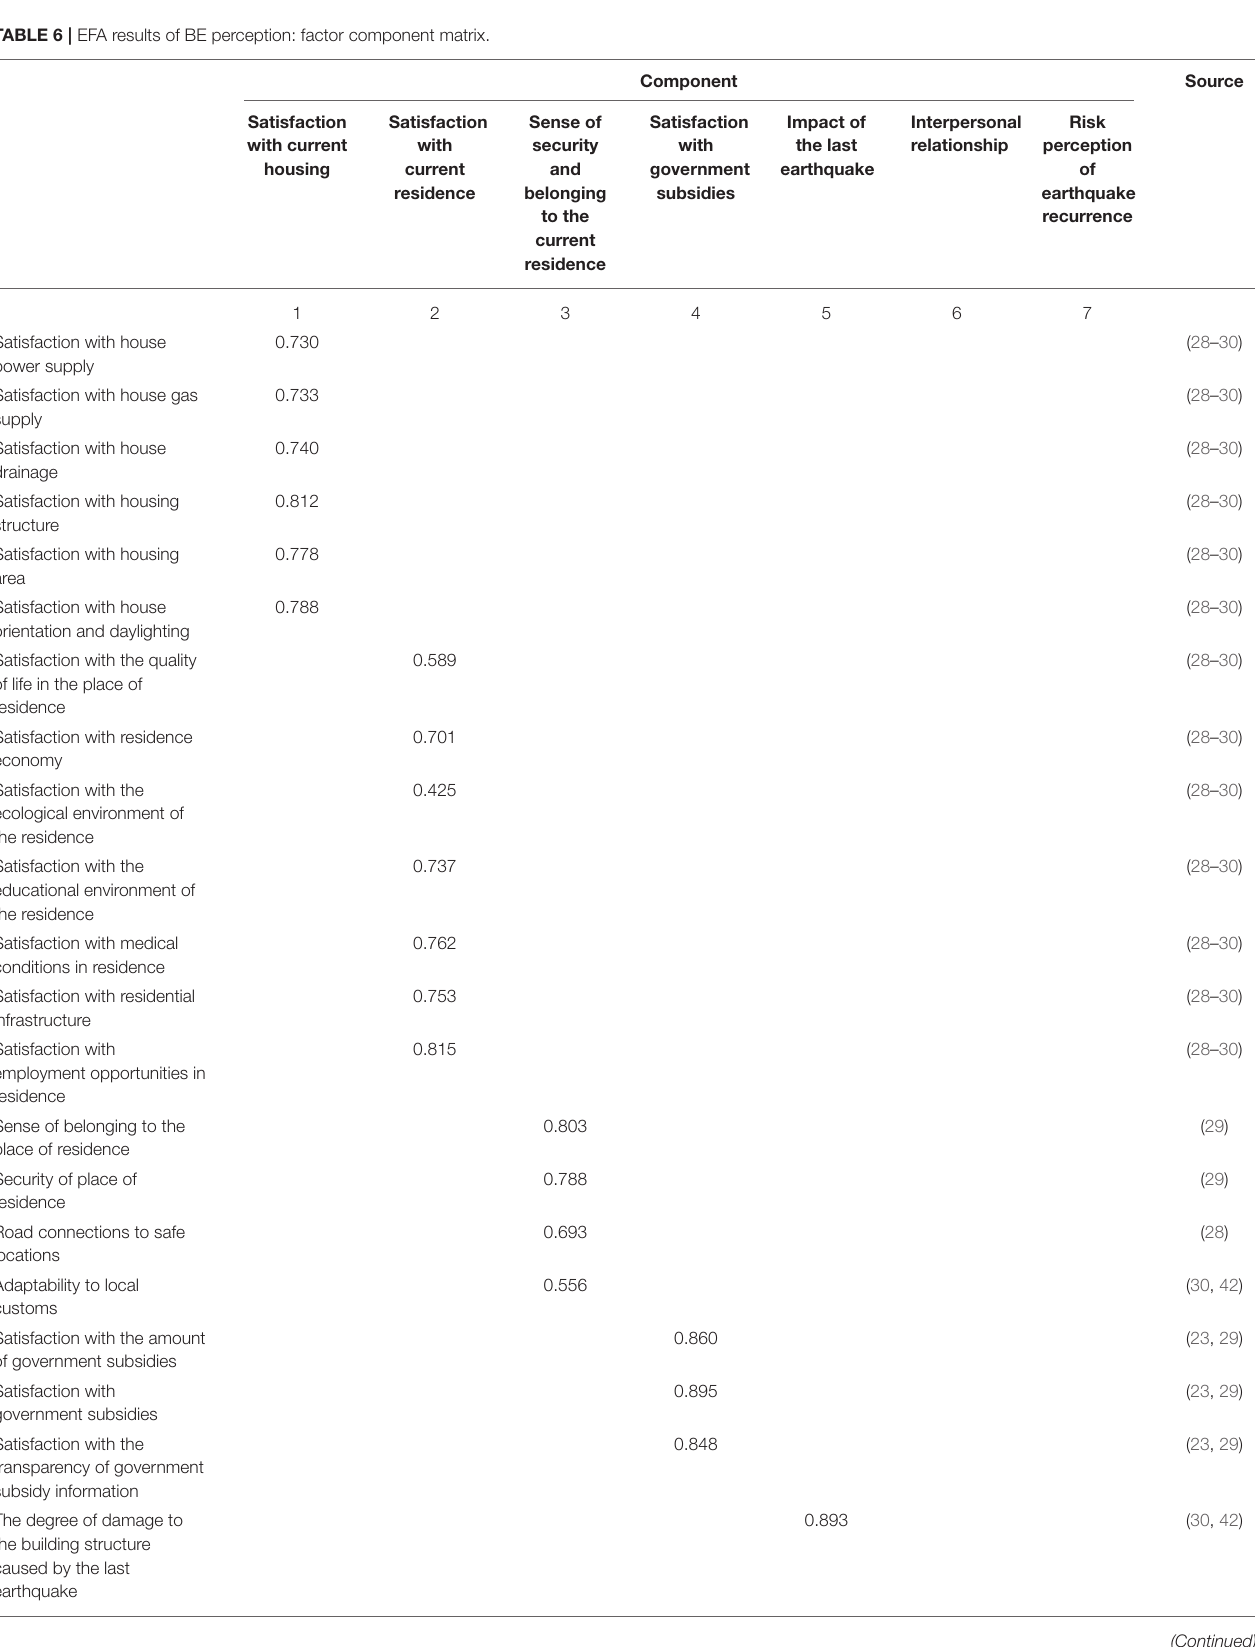
TABLE 6 | EFA results of BE perception: factor component matrix.